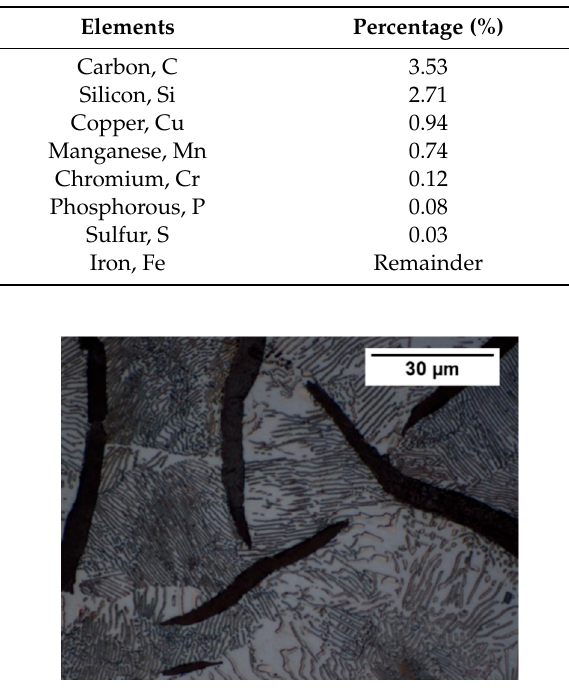
Table 1. Chemical Percentage of Gray Cast Iron.